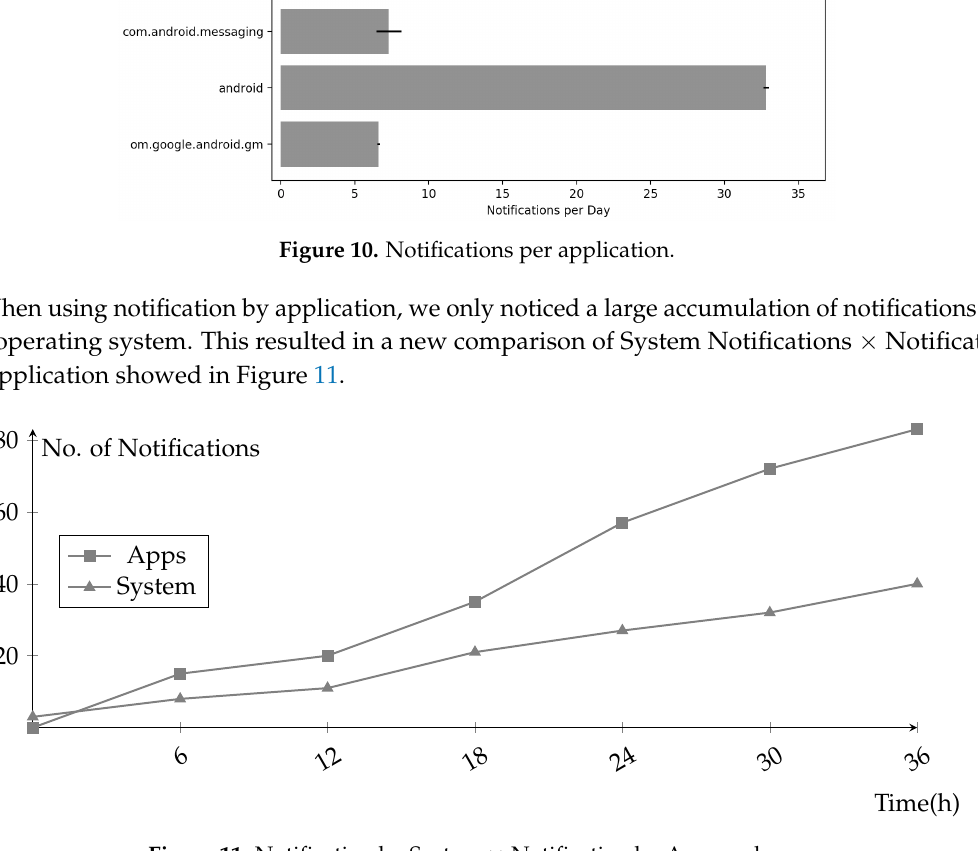
Figure 11. Notification by System × Notification by App per